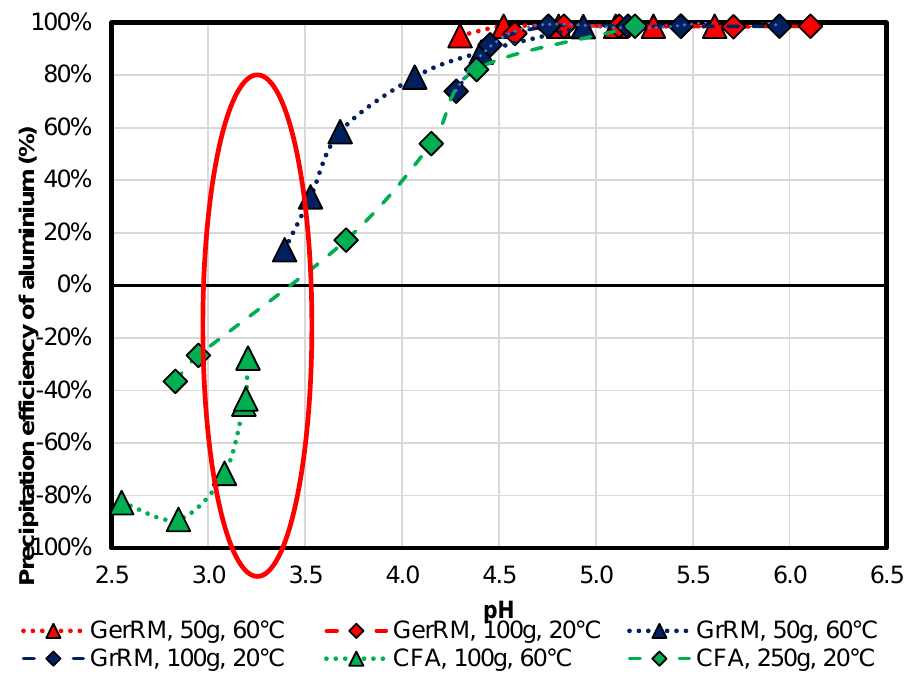
Figure 9. Participation efficiency of aluminium.